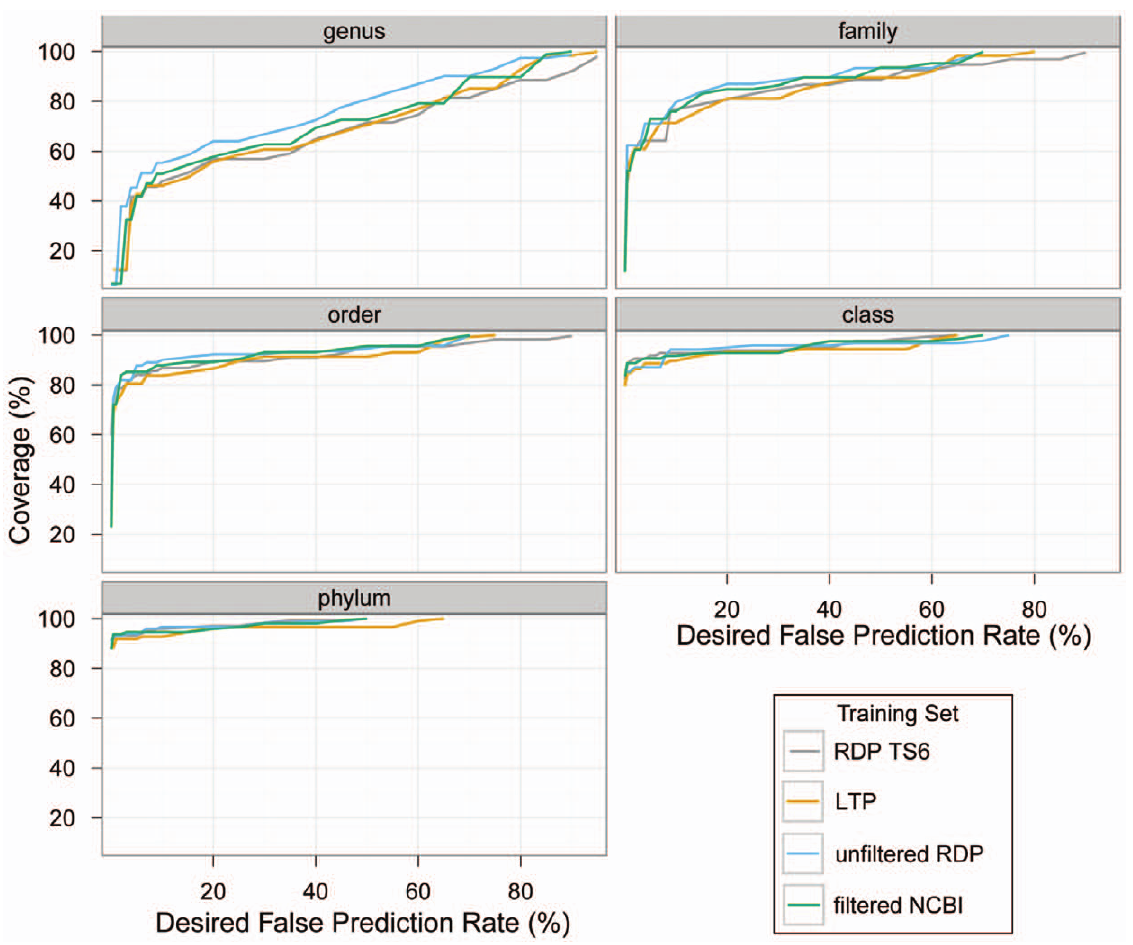
Figure 1. Performance of different training sets in the classification of 100 nt reads from the V4 amplicon. Each panel compares the performance of the training sets (described in Table 1) for a different rank. We used the results of leave-k-out tests classifying the LTP sequences to determine confidence score thresholds for a set of desired false prediction rate (FPR) values (x axis), so that the FPR would be at most the desired value. We then used these thresholds to calculate the classification coverage of sequences from environmental (uncultured) bacteria that corresponds to the desired FPR (y axis).